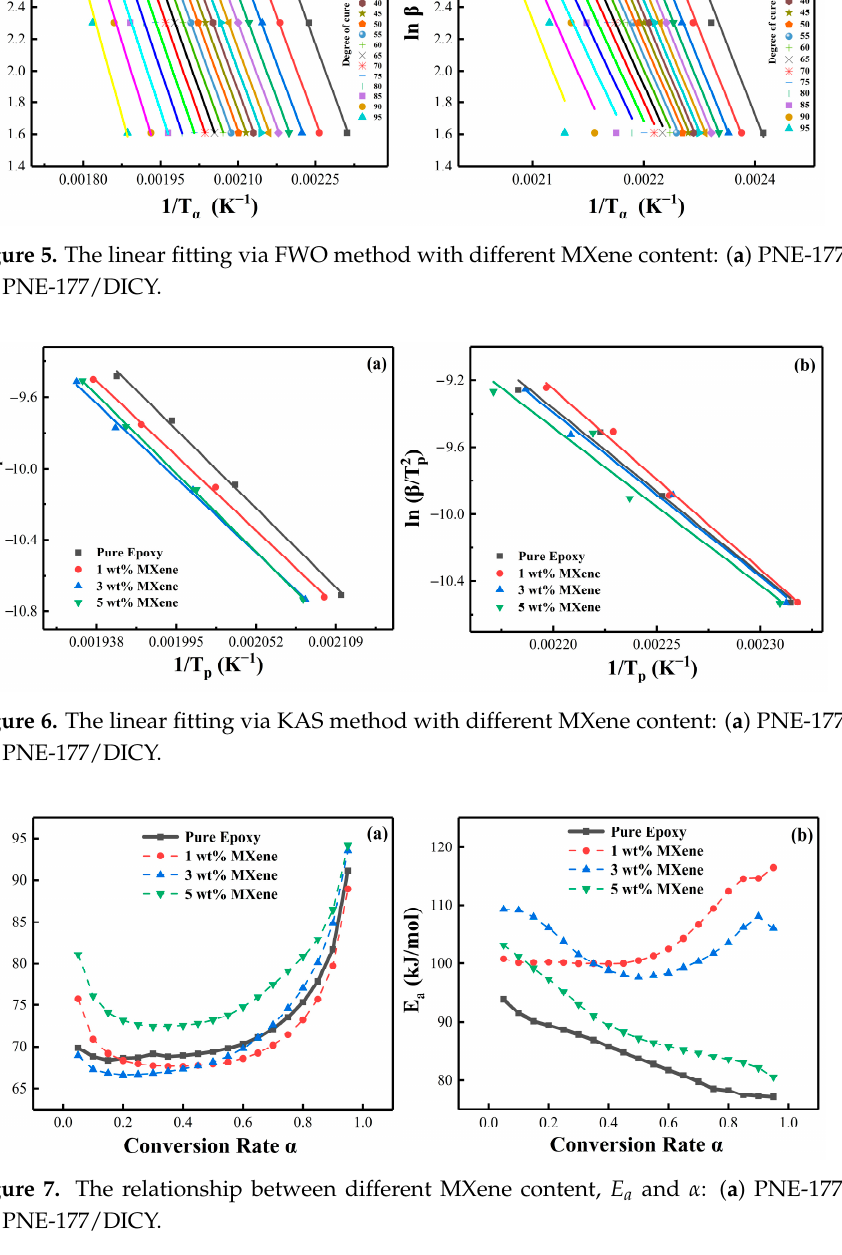
Figure 7. The relationship between different MXene content, E a and α : ( a ) PNE-177/DDS and ( b ) PNE-177/DICY. Table 3. The activation energy of PNE-177/DDS and PNE-177/DICY systems based on both fitting methods.